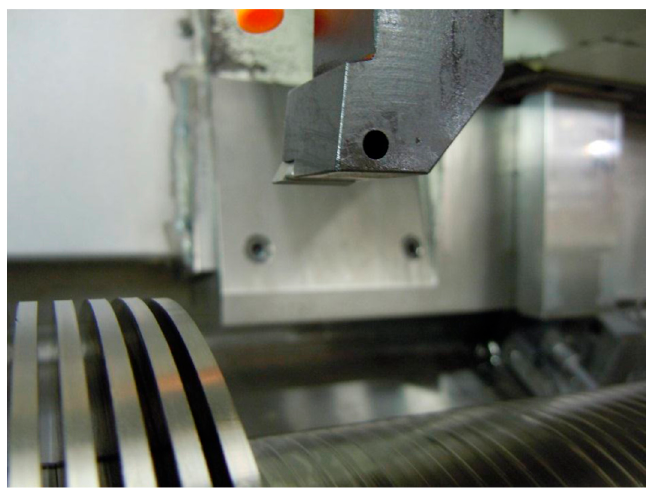
Figure 2. Test set-up for orthogonal turning tests using a flanged Ti6Al4V work piece.